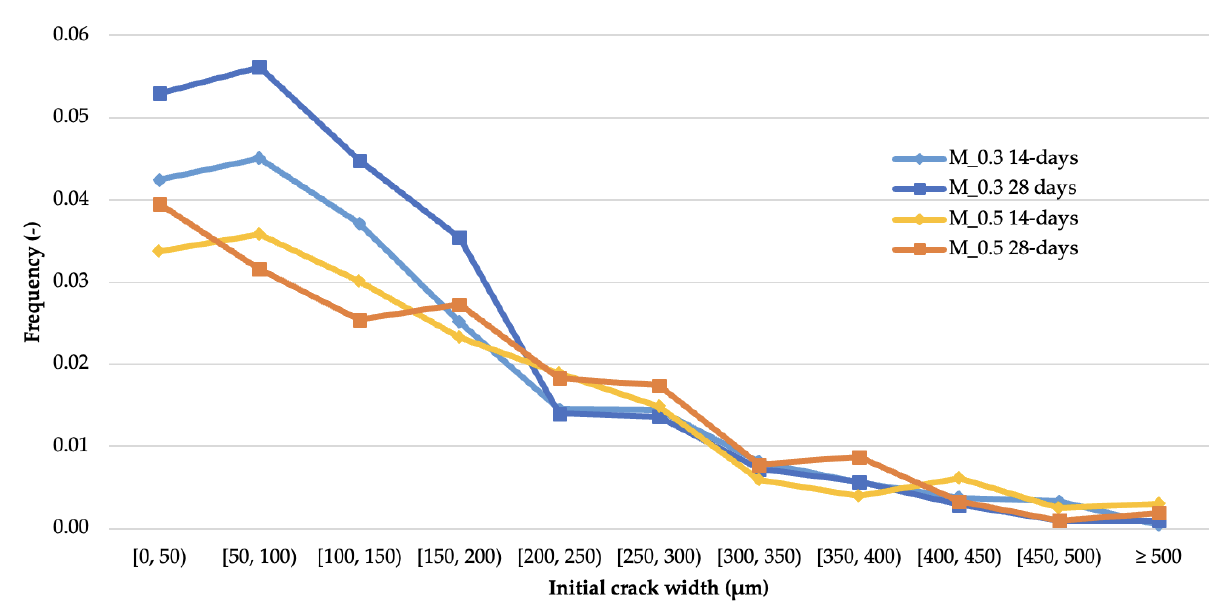
Figure 6. Frequency of full crack closure in ranges of initial crack width after 122 days of self-sealing.